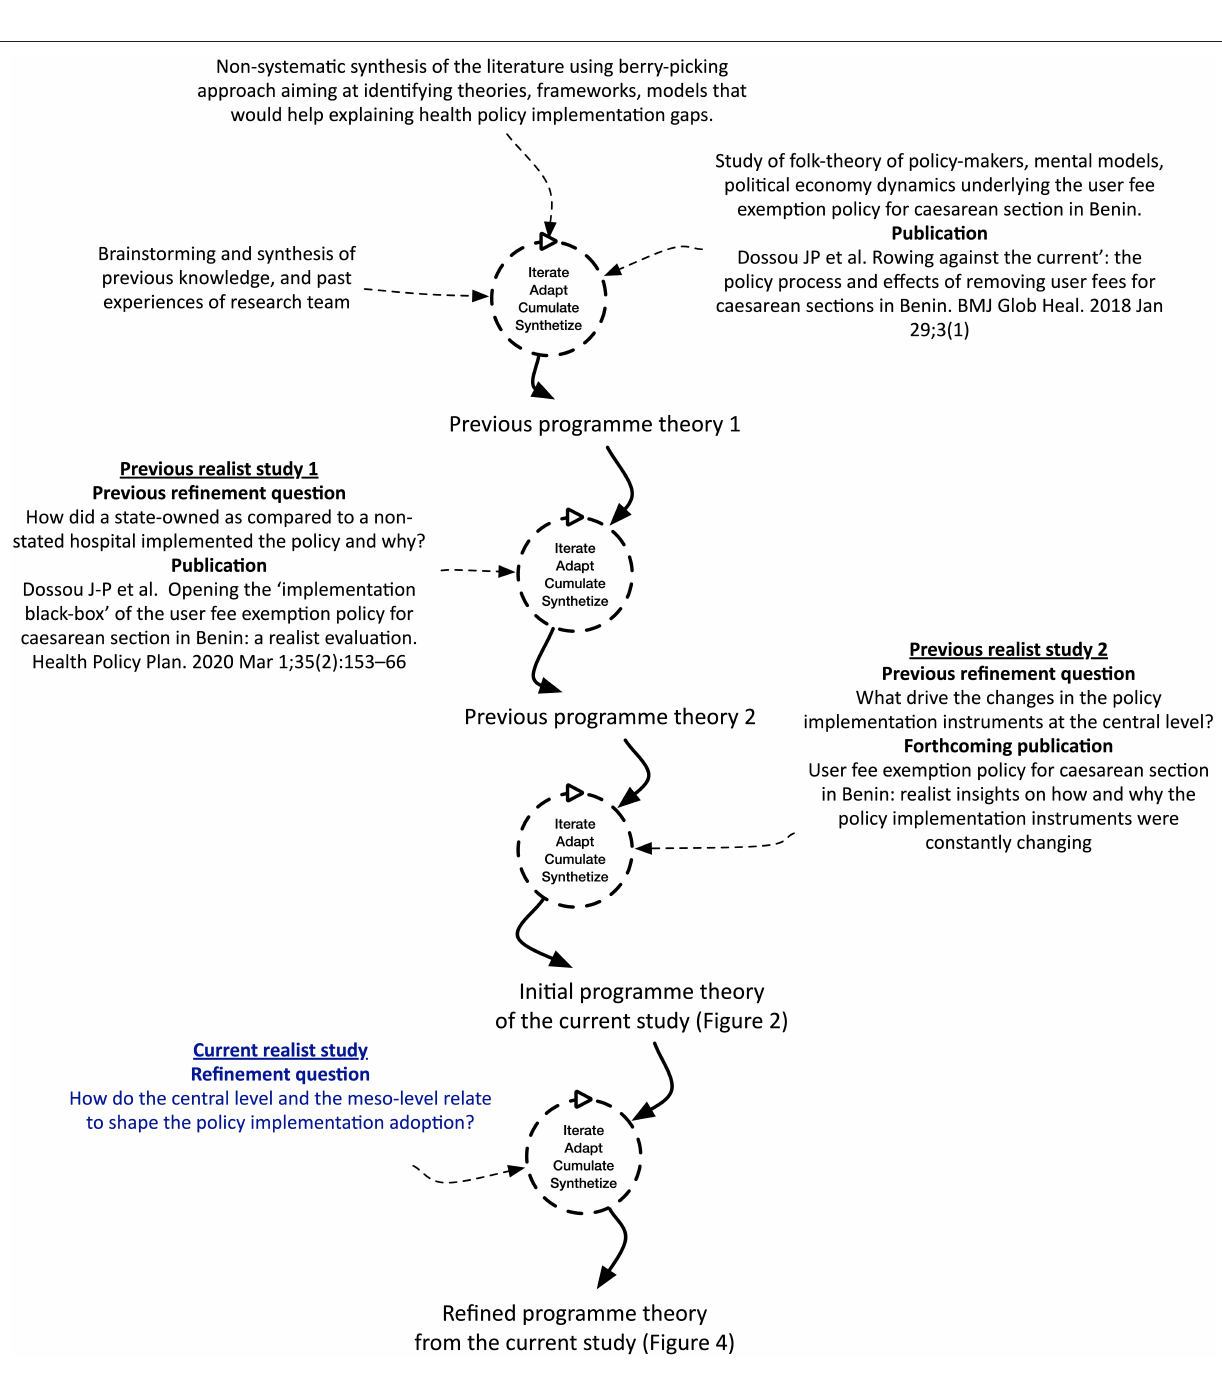
FIGURE 1 | Summary of the research process linking the previous studies with the current